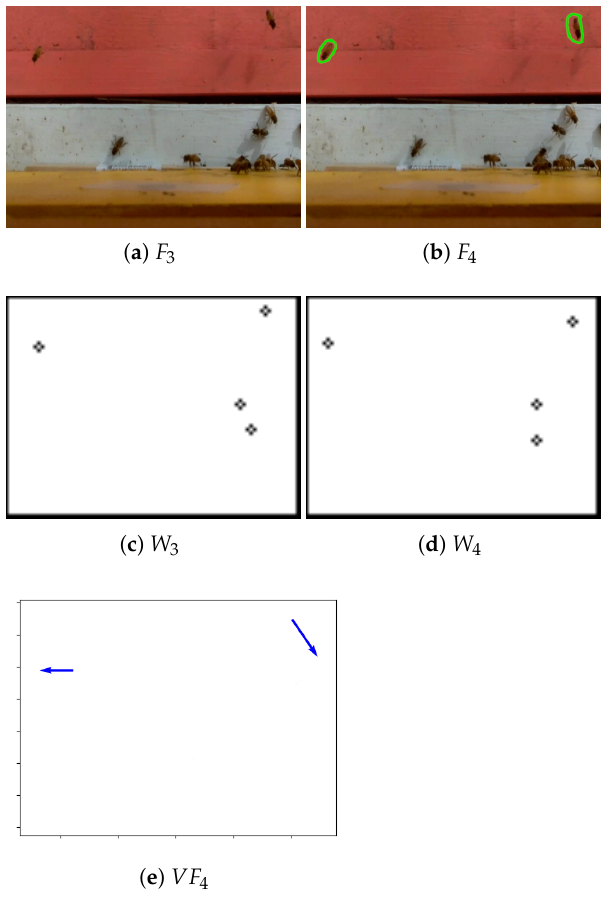
Figure 13. F 3 and F 4 are original frames from12 to frame video in Figure 2 with two moved bees marked with green polygons in F 4 ; W 3 and W 4 are corresponding motion frames obtained from F 3 and F 4 , respectively; vector field VF 4 is generated from W 3 and W 4 with PIV in Equation